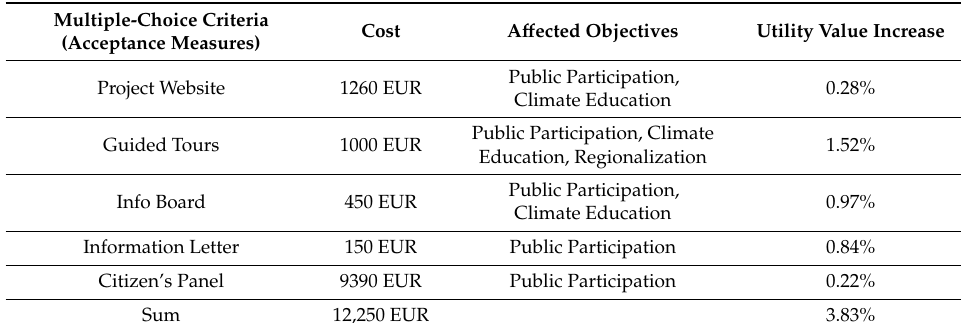
Table A3. Multiple-choice